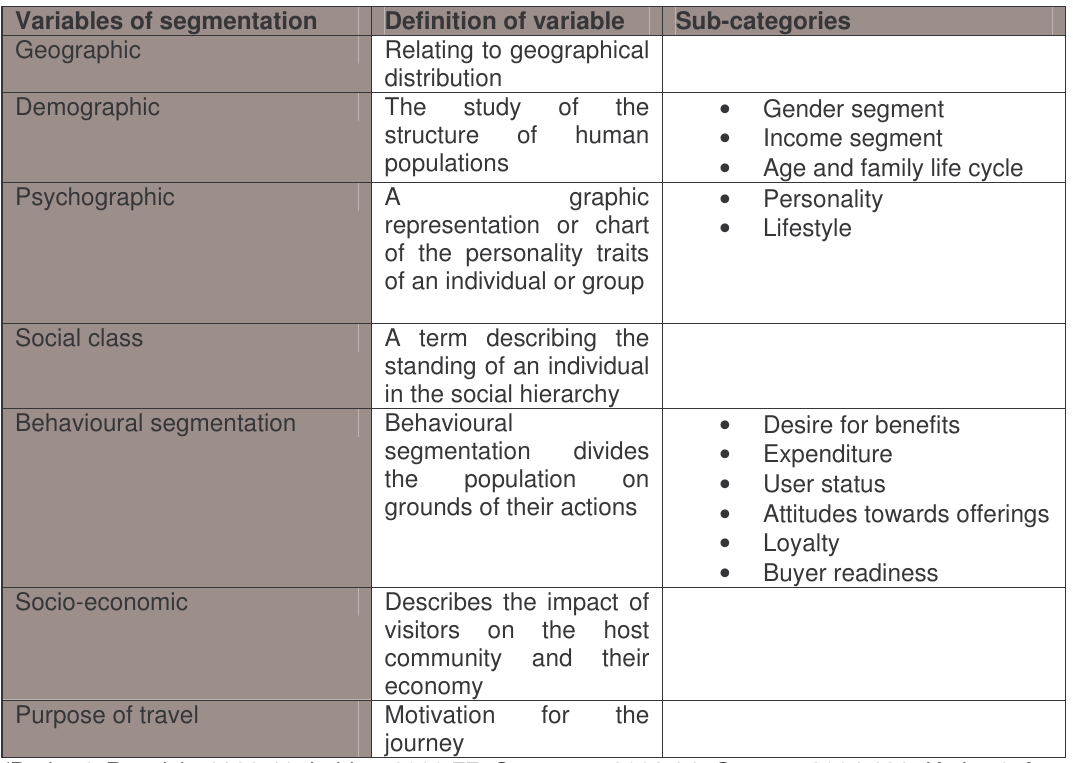
Table 1: Segmentation variables Variables of segmentation Definition of variable